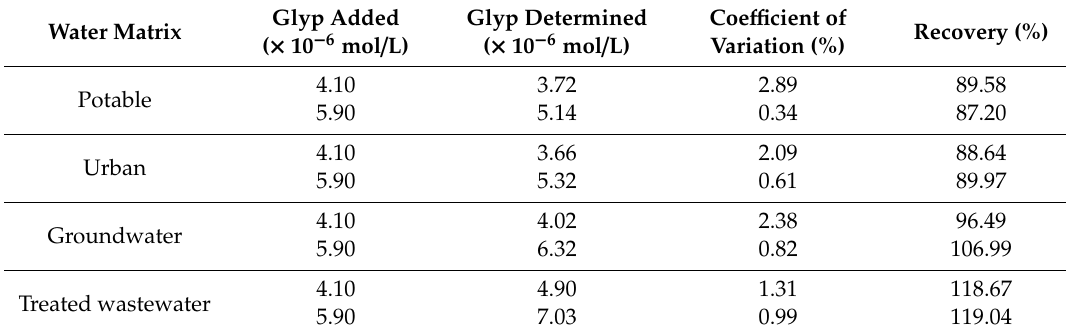
Table 4. Detection of glyp in spiked water